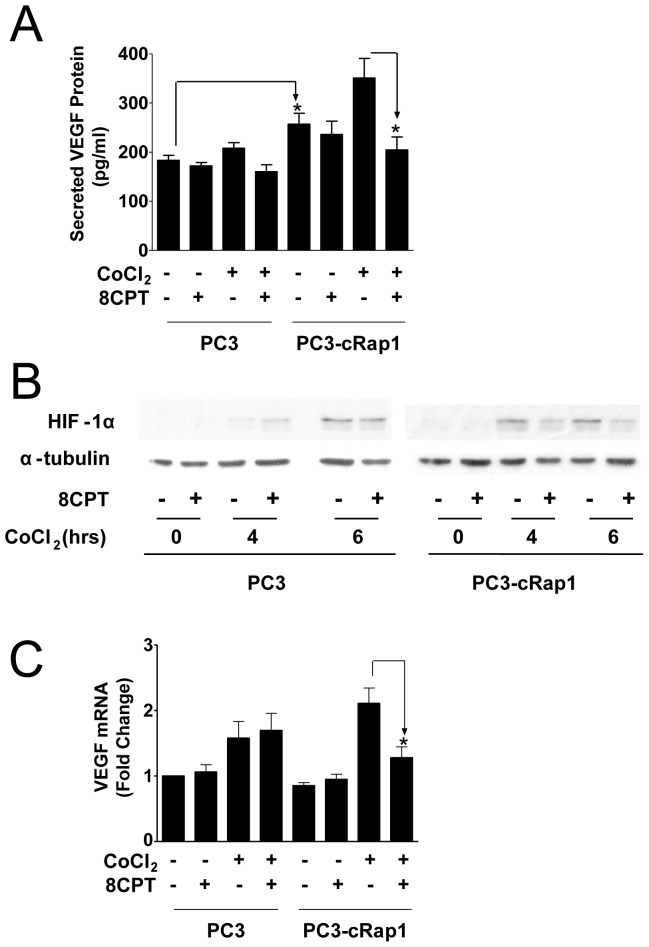
Effect of 8CPT treatment on HIF-1α and VEGF in PC3 and PC3-cRap1 cells under hypoxic-like conditions.(A) VEGF levels were measured by ELISA in PC3 and PC3-cRap1 cells under hypoxic-like conditions (CoCl2) as described in Methods; *p<0.05, (n = 3). (B) Immunoblot analysis of nuclear extracts from PC3 and PC3-cRap1 cells treated as indicated. HIF-1α protein levels were determined by immunoblotting with specific antibody; (C) Analysis of VEGF mRNA levels by qPCR in PC3 and PC3-cRap1 cells treated as indicated. Data were normalized to GAPDH levels; *p<0.05 (n = 3).